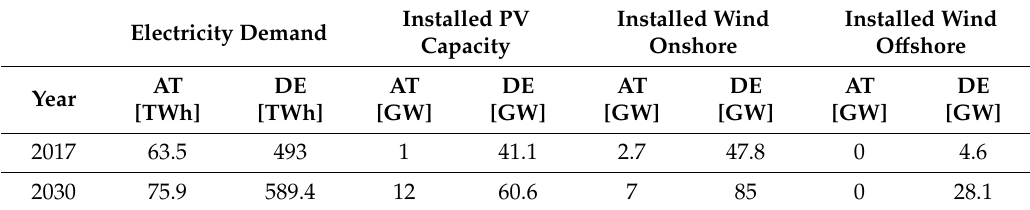
Table 1. Electricity demand and installed renewable capacities as input for the electricity market model